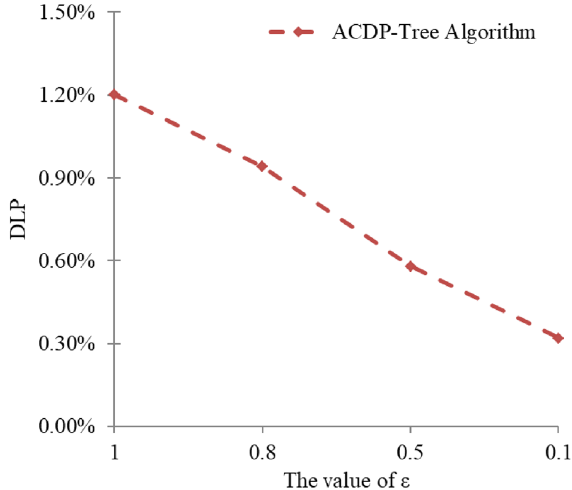
Figure 5. DLP variation trend under different privacy